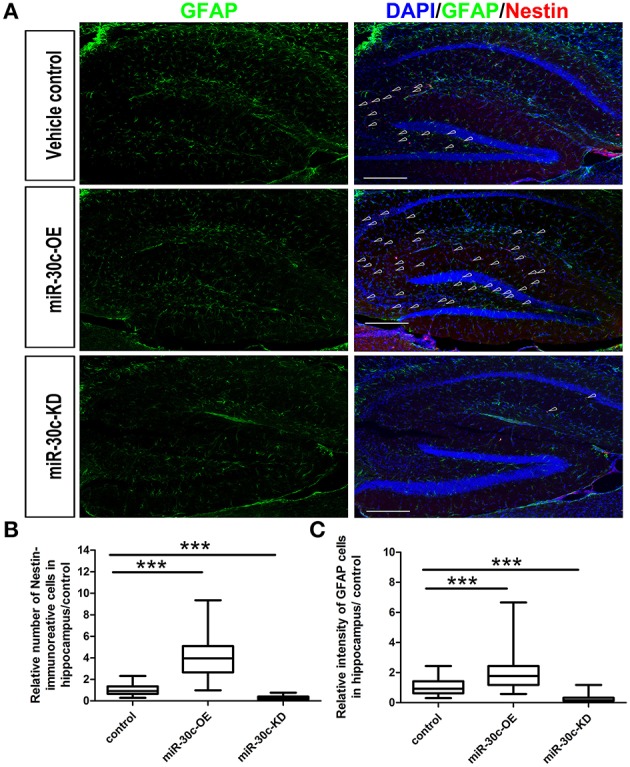
Neuronal lineage alterations in the DG induce by miR-30c. (A) Lineage alteration induced by miR-30c in DG. Nuclei were stained with DAPI; astrocyte, characterized with GFAP-immuoreactive cells; Stem cells were marked with Nestin-immoreactive cells. Scale bars, 100 μm. (B,C) Statistic analyses of the number of Nestin-immunoreactive (stem cells) and GFAP-immunoreactive cells (precursor of neuroblasts) in hippocampus. All data were normalized to the average value of the control, ***p < 0.001 determined by one-way ANOVA followed by Bonferroni multiple comparison tests; n = 60 sections, four mice/group.